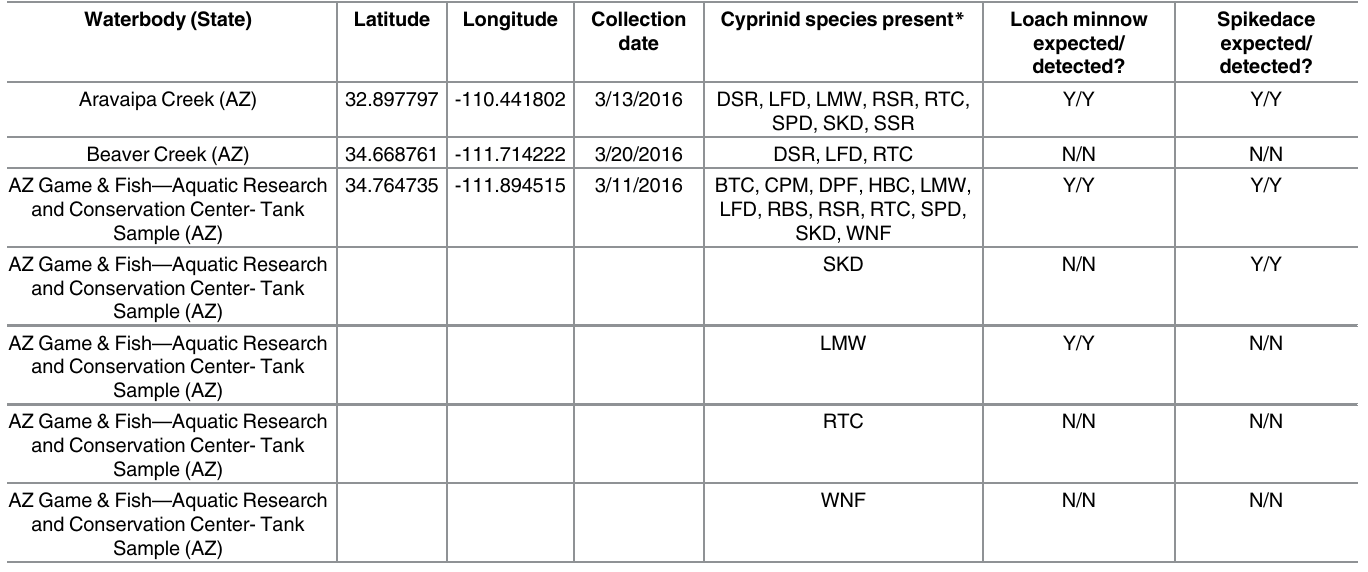
Table 4. Collection and species assemblage information for eDNA samples used to test the loach minnow and spikedace qPCR assays. Waterbody (State)